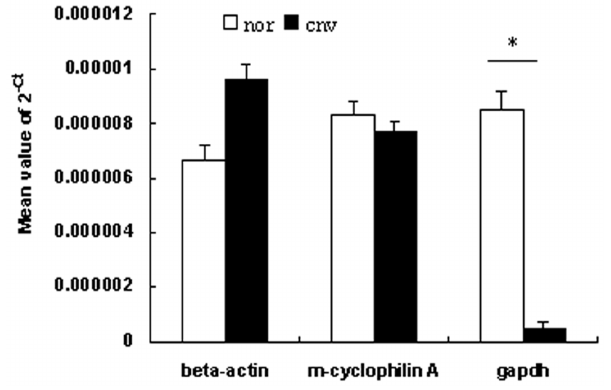
Figure 1. Validation of endogenous control genes in lasered and unlasered mice eyes. 5–8-week-old female C57BL/6 mice were prepared for validation of such endogenous control genes as m- cyclophilin A, beta-actin and gapdh. Three days after photocoagulation at 10 locations per eye, the mRNA expression levels of these three housekeeping genes in eyecups were compared with those of age- matched unlasered eyes. In order to determine whether the expression of the potential internal control gene varies under the experimental conditions, the realtime PCR data was presented from the replicate cDNAs as 2 2 Ct and Student’s t-tests were performed between the treated and untreated groups as described [9]. The fold changes in the three genes in the treated samples compared to the untreated samples were 1.44 for b -actin, 0.94 for cyclophilin A, and 0.06 for gapdh. Student’s t-tests showed that there was significant difference between the treated and untreated samples in gapdh expression (P , 0.01), but none in b -actin (P=0.14) or cyclophilin A (P=0.93). This suggests that cyclophilin A is presumably the most suitable endogenous control among these three